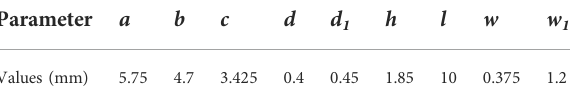
TABLE 1 Related geometric parameters about